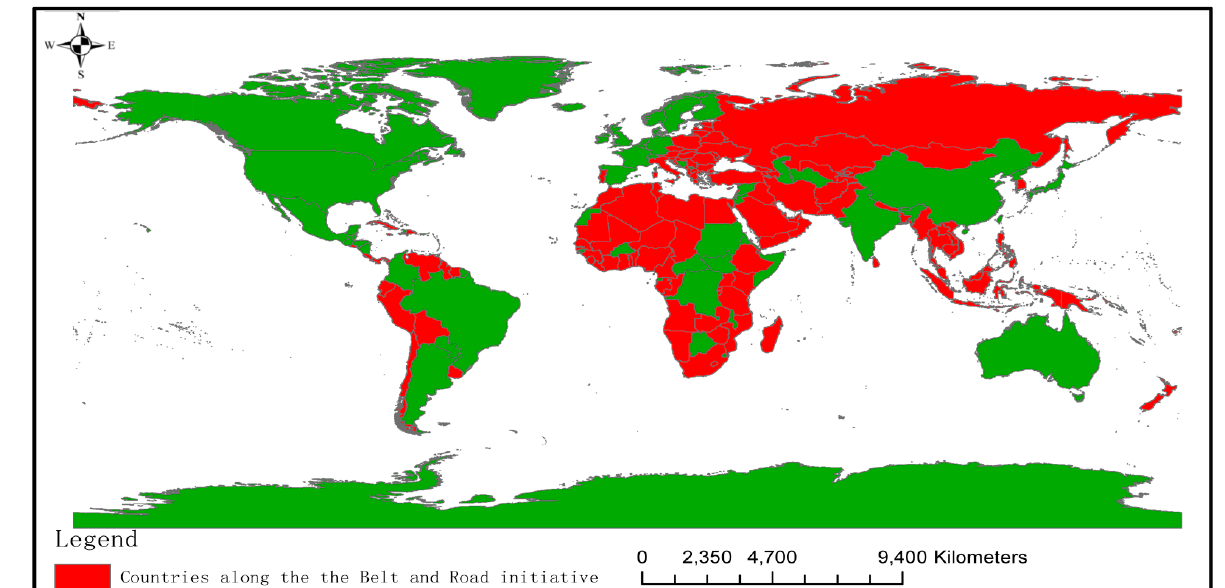
Figure 1. Graphical distribution of countries along with the “belt and road initiative”. The data are mainly extracted from the World Bank statistics